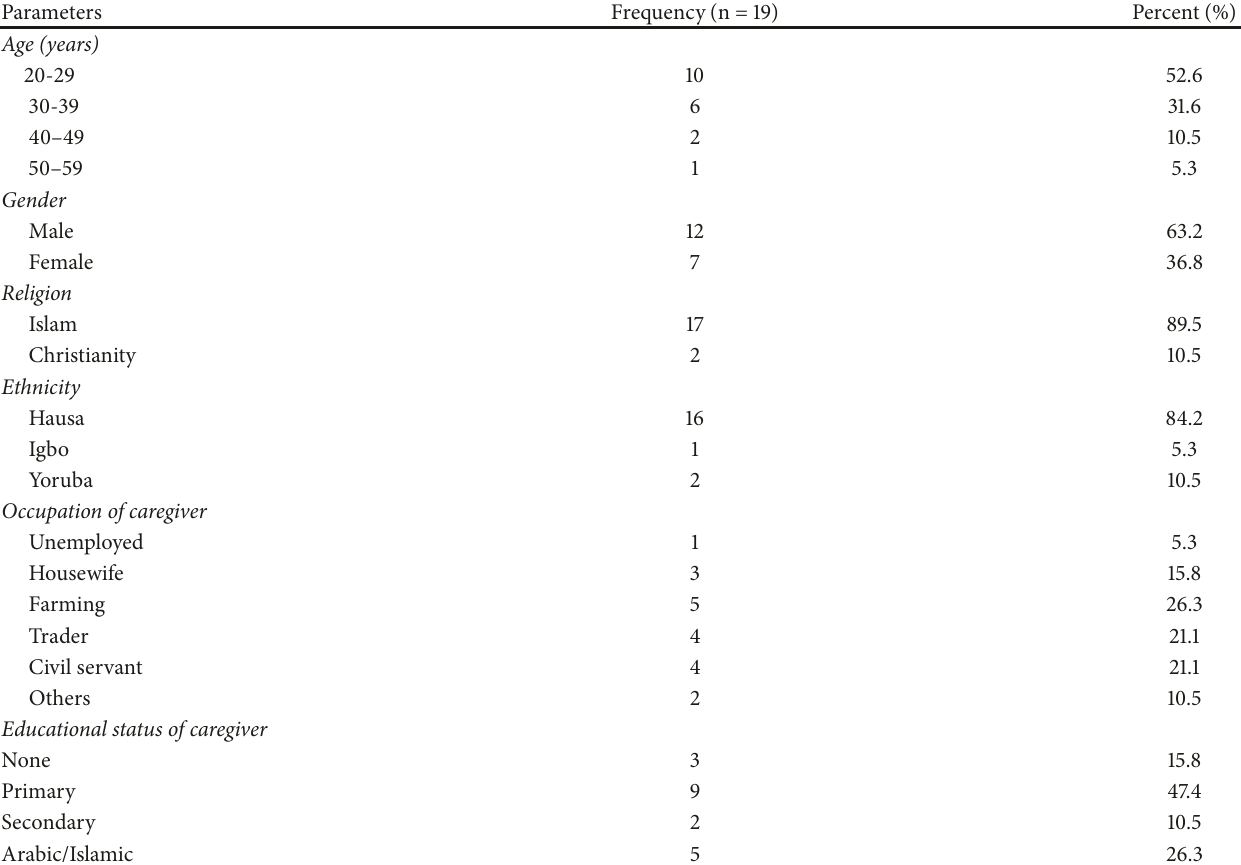
Table 1: Sociodemographic profile of participants.